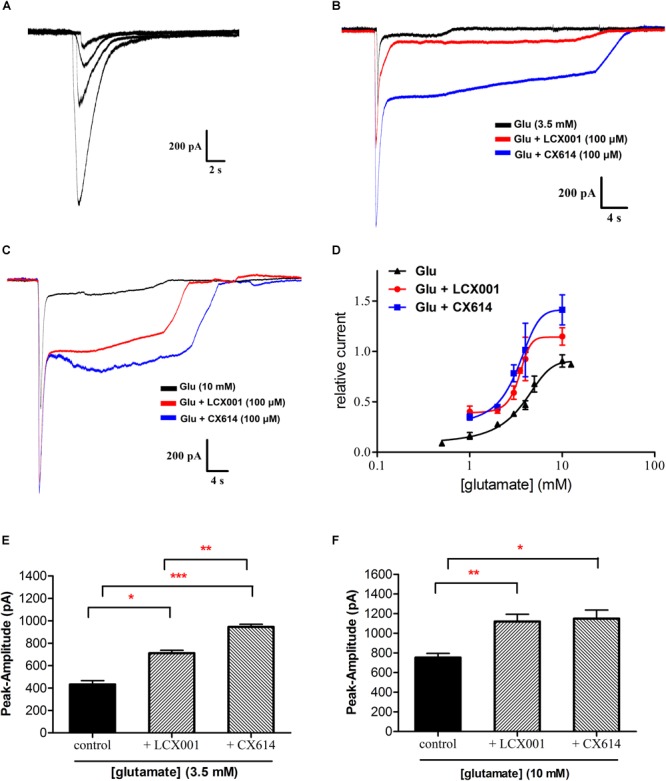
LCX001 facilitated apparent affinity of glutamate and increased glutamate-induced amplitudes. Representative traces were obtained from HEK293 cells expressing recombinant homomeric GluA2(R)flop receptor. (A) Typical response to application of glutamate at increasing doses (1–5 mM) in a whole-cell clamp-patch recording. (B) 3.5 mM glutamate evoked currents in the absence and presence of 100 μM LCX001 or CX614. (C) 10 mM glutamate evoked currents in the absence and presence of 100 μM LCX001 or CX614. (D) Concentration-response profile of glutamate-mediated currents alone and in the presence of 100 μM LCX001 or CX614. Values of amplitudes were normalized to the current from 10 mM glutamate in the same patch. The data were fitted by a Hill-type equation, and the EC50 obtained from the fits was given in the text. The nH values of glutamate alone and in the presence of LCX001 or CX614 were 0.3, 0.84, and 0.43 respectively. (E,F) 100 μM LCX001 and CX614 were efficacious at enhancing glutamate (3.5 and 10 mM) evoked peak amplitudes. ∗Significant difference by one-way ANOVA, Dunnett’s test (LCX001 or CX614 treatment group vs. control group;∗P < 0.05,∗∗P < 0.01 and ∗∗∗P < 0.001); mean ± SEM, n = 6.